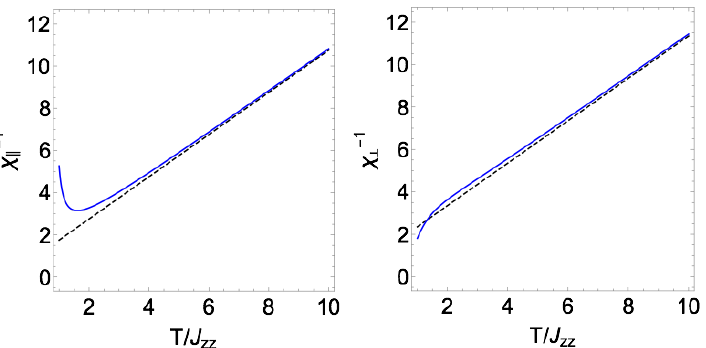
Figure 2: Susceptibilities versus temperature. The dashed black lines show the Curie- Weiss law, and the solid blue lines plot the inverse of equation (9). The parameters are chosen to be J plot, χ (cid:107) and χ ⊥ , are in units of µ